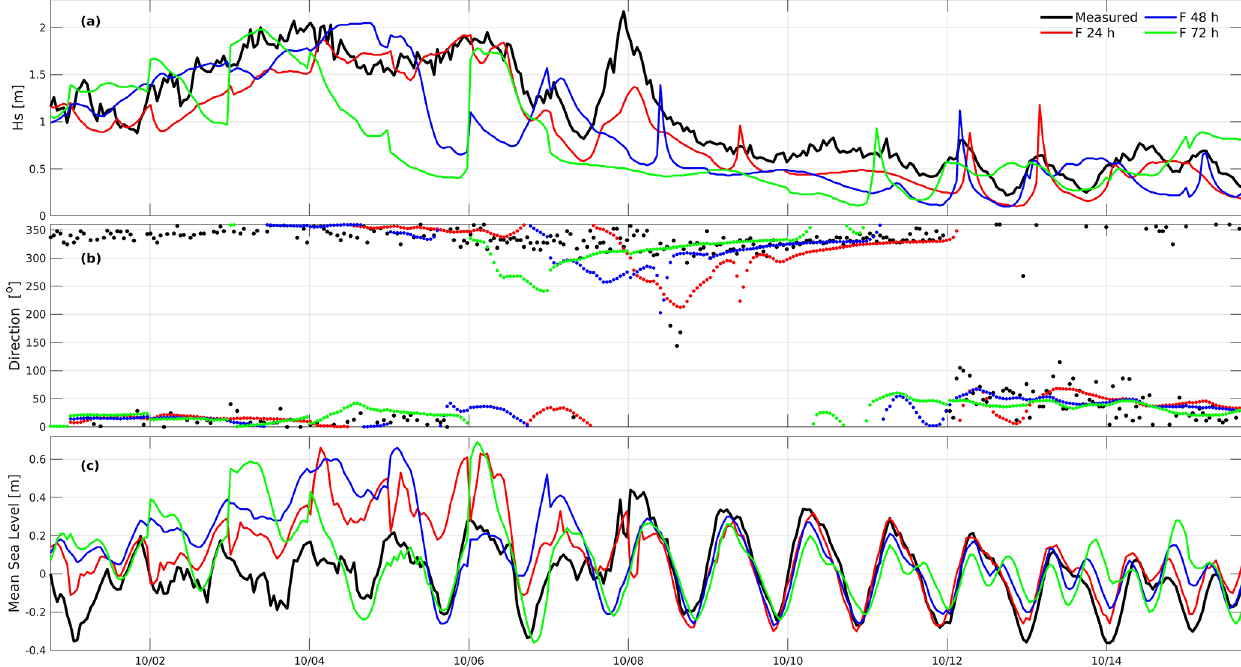
Figure 12. Measured (black line) and forecast modeled time series of (a) significant wave height, (b) wave direction, and (c) sea level anomaly. The red line indicates the 24h forecast, the blue line the 48h forecast, and the green line the 72h forecast of WWIII for (a) and (b) and of the ADCIRC model for (c) in Sisal, Yucatán, from 1 to 15 October 2020. The date format is mm/dd.